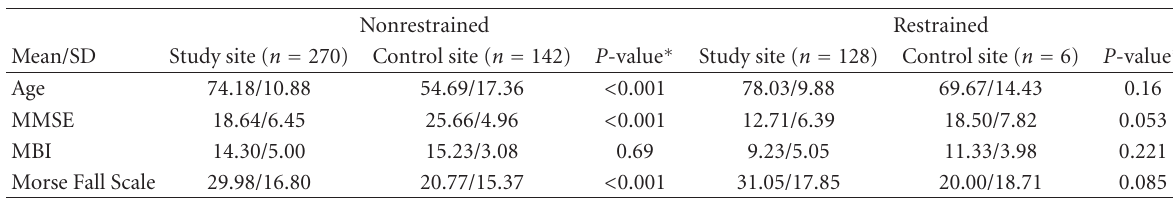
(a) Sample profile before intervention (I)